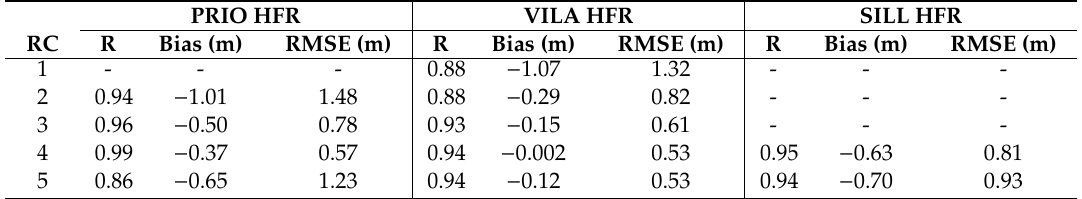
Table A4. Correlation (R), bias and RMSE (statistic metrics) between SRAL and HFR SWH for each RC, considering the distance from the coast—4.86 MHz HFR sites (PRIO, VILA, and SILL).